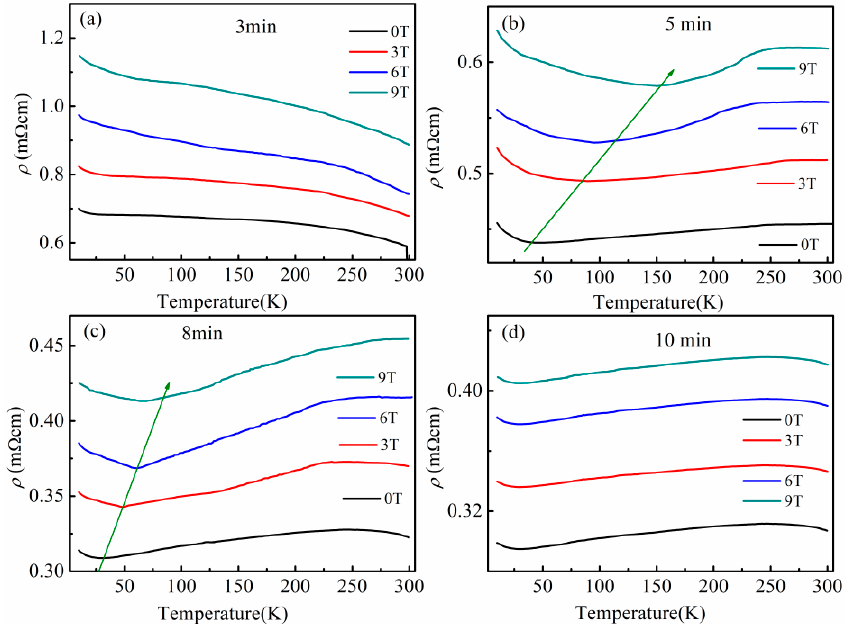
Figure 5. The resistivity of Bi 2 Se 3 /LSMO/LAO deposited at different times varies with temperature at different applied fields: ( a ) 3 min; ( b ) 5 min; ( c ) 8 min; ( d ) 10 min.